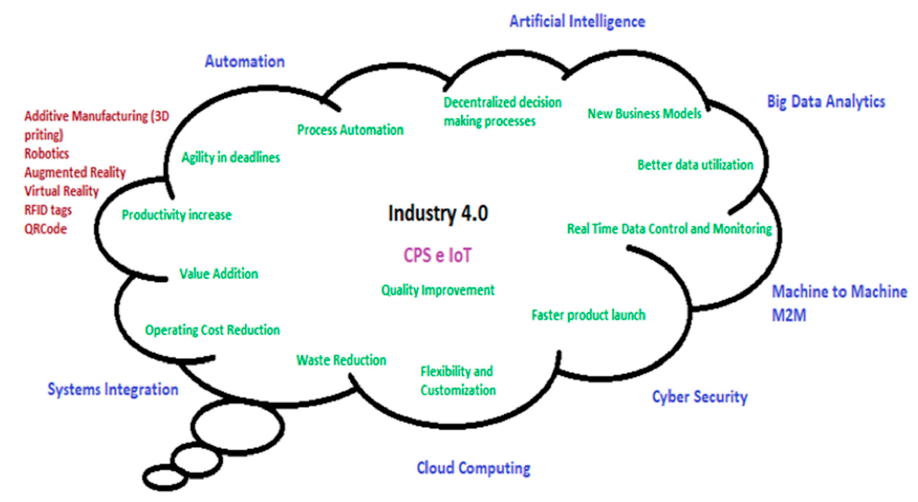
Figure 5. The main technological elements of I4.0.